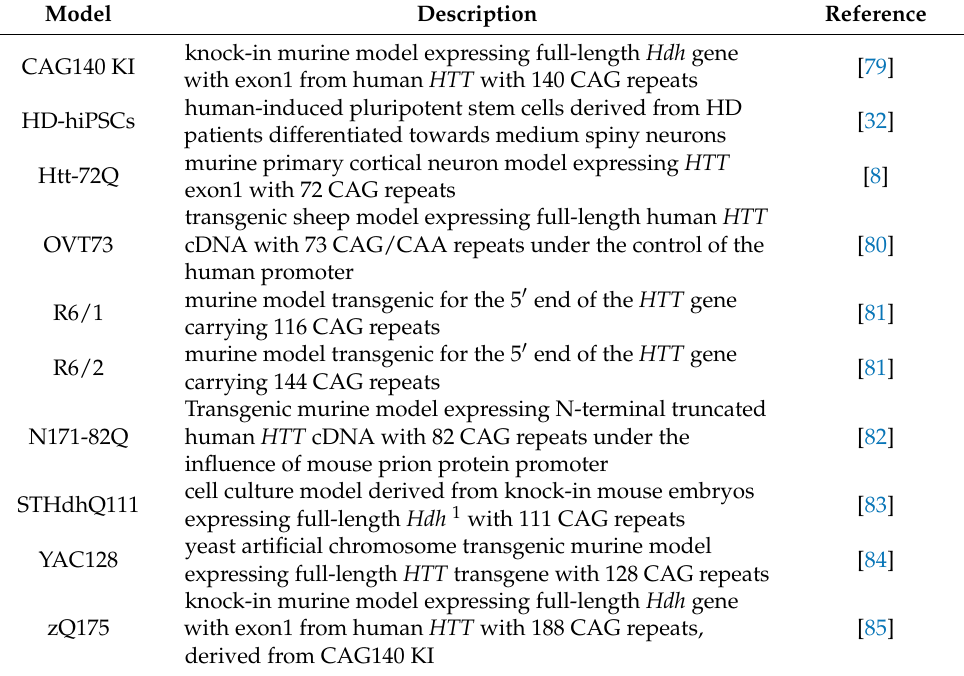
Table A1. List of Huntington’s disease models used in the reviewed studies.